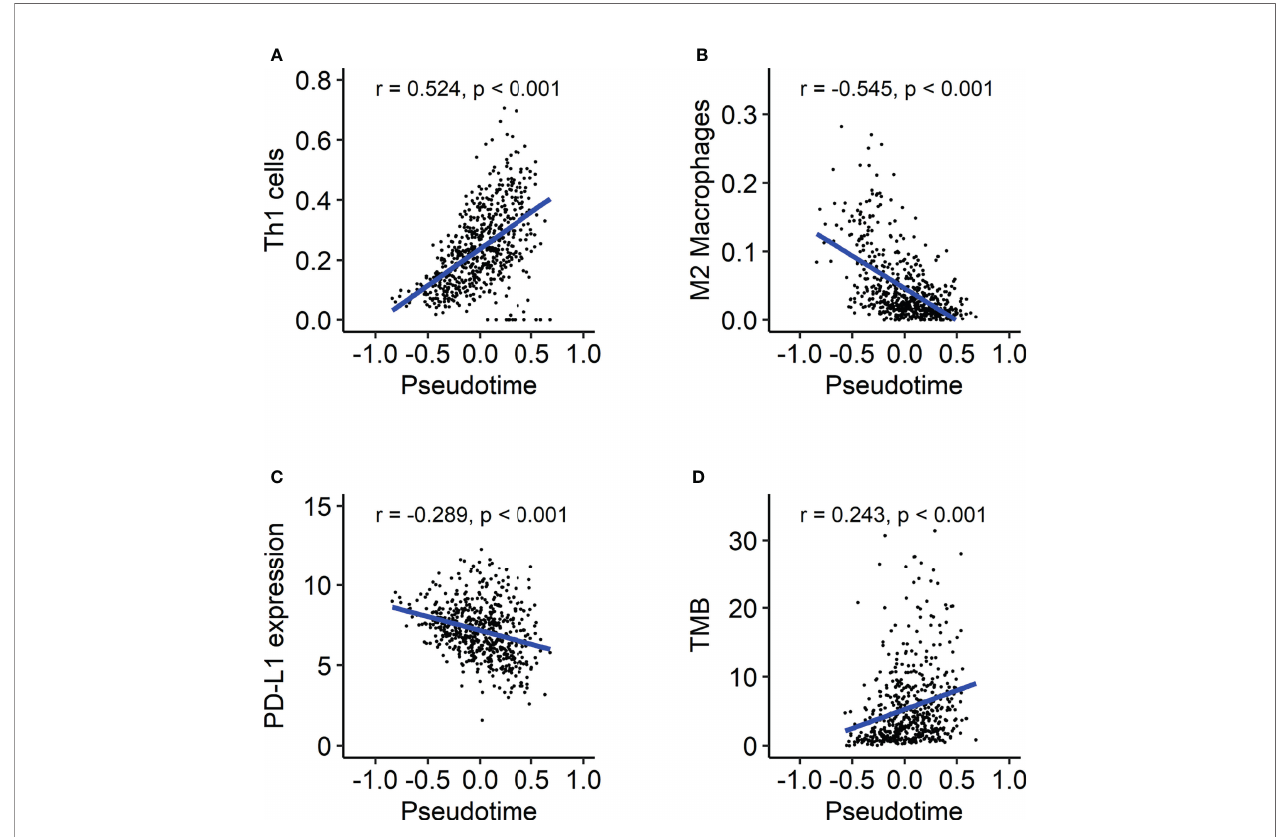
FIGURE 7 | Evolution of the tumor immune microenvironment over pseudotime in the TCGA-LUAD dataset. (A) Th1 cells showed a positive correlation with pseudotime (r = 0.524, p < 0.001). (B) M2 macrophages showed a negative correlation with pseudotime (r = -0.545, p < 0.001). (C) PD-L1 expression showed a weakly negative correlation with pseudotime (r = -0.289, p < 0.001). (D) TMB showed a weakly positive correlation with pseudotime (r = 0.243, p <